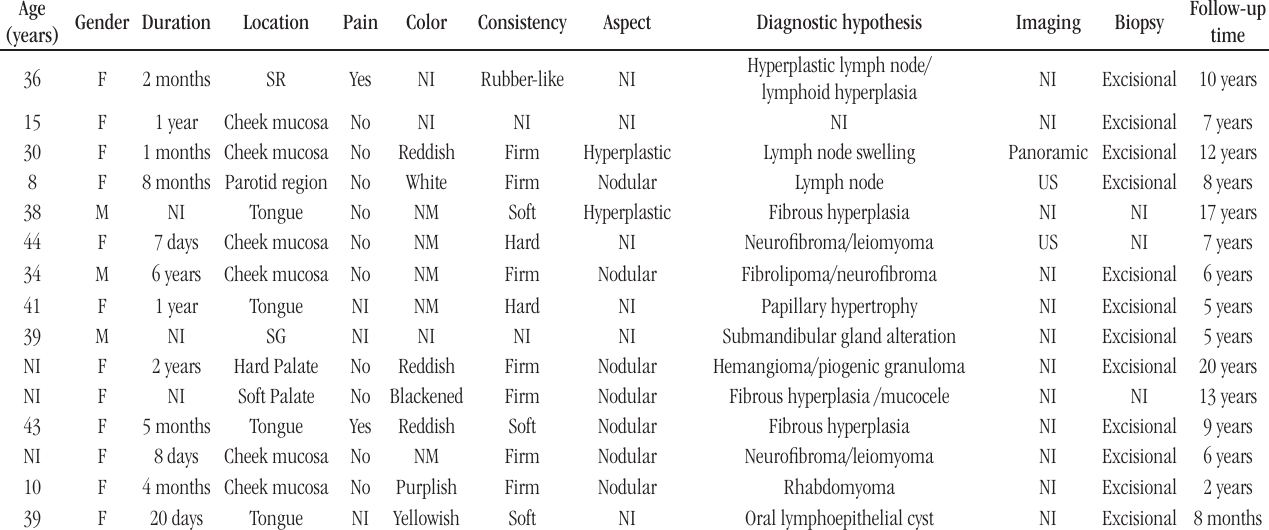
TABLE 2 – Clinical characteristics of fifteen cases of oral follicular lymphoid hyperplasia